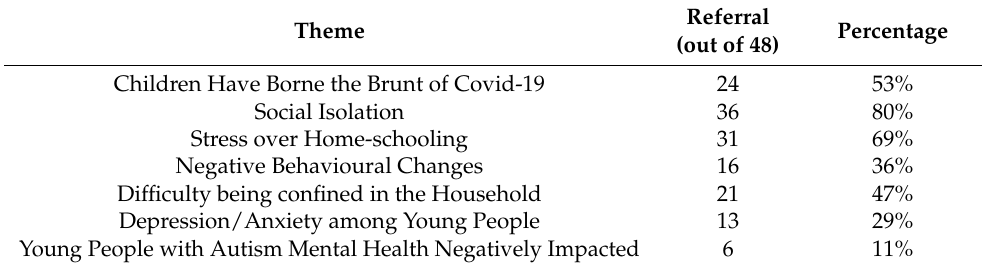
Table 2. The referral and percentage of qualitative themes in this data set. Referral Percentage Theme (out of 48) Children Have Borne the Brunt of Covid-19 24 53% Social Isolation 36 80% Stress over Home-schooling 31 69% Negative Behavioural Changes 16 36% Difficulty being confined in the Household 21 47% Depression/Anxiety among Young People 13 29% Young People with Autism Mental Health Negatively Impacted 6